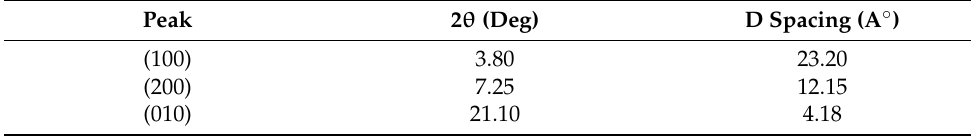
Figure 4. GIXRD pattern of annealed P(FDPP-TP) thin films at different temperatures on SiO 2 substrates treated with octadecyl trimethoxy silane (OTMS). Table 1. GIXRD data of the P(FDPP-TP)